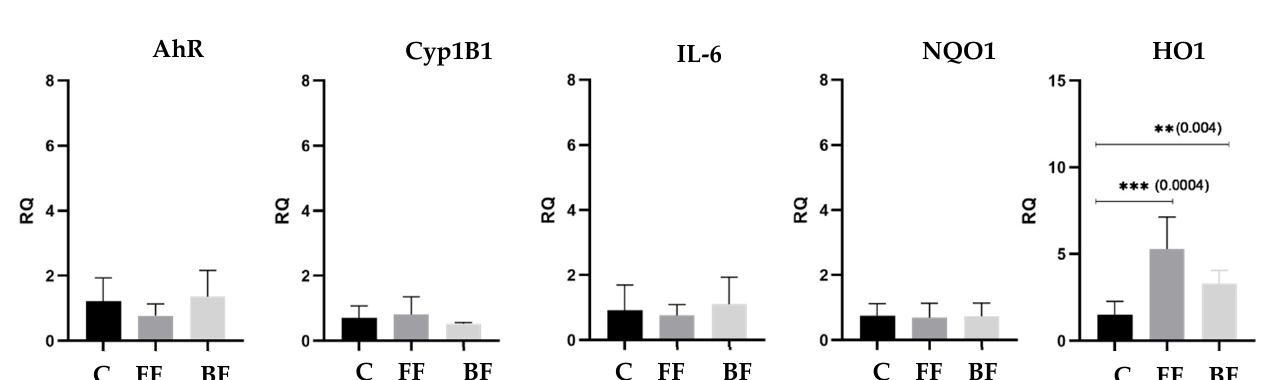
Figure 2. Differential gene expression after exposure to filtered air (C), fossil fuel emissions (FF), and biofuel blend emissions (BF).